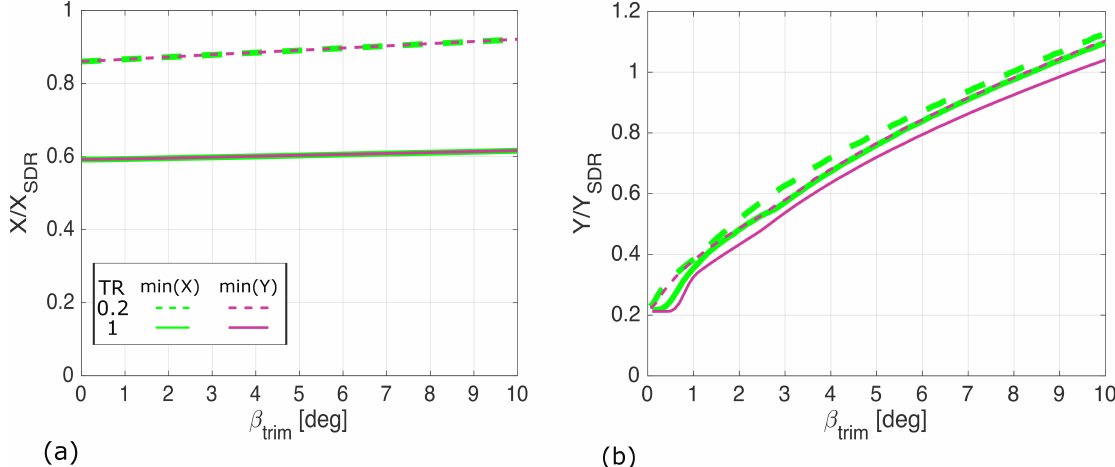
Figure 14. Optimisation functions aerodynamic efficiency ( a ) and aggregate control deflection ( b ) objectives for a 45 degree swept wing normalised by the same metrics for a SDR. Variations are shown up to a given sideslip trim angle of 10